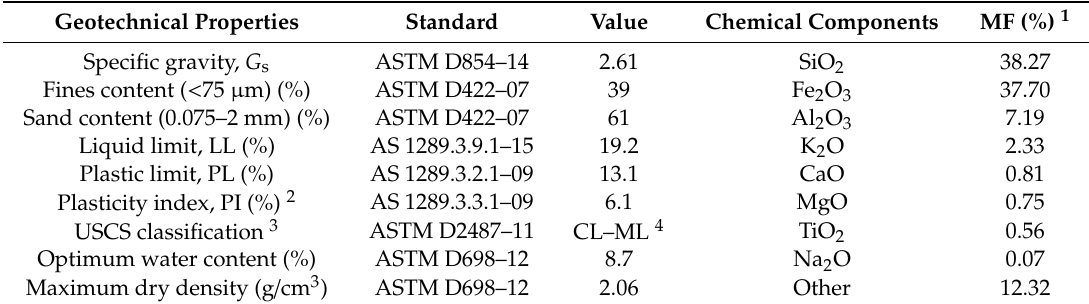
Table 1. Geotechnical properties and chemical composition of the mine tailings. Geotechnical